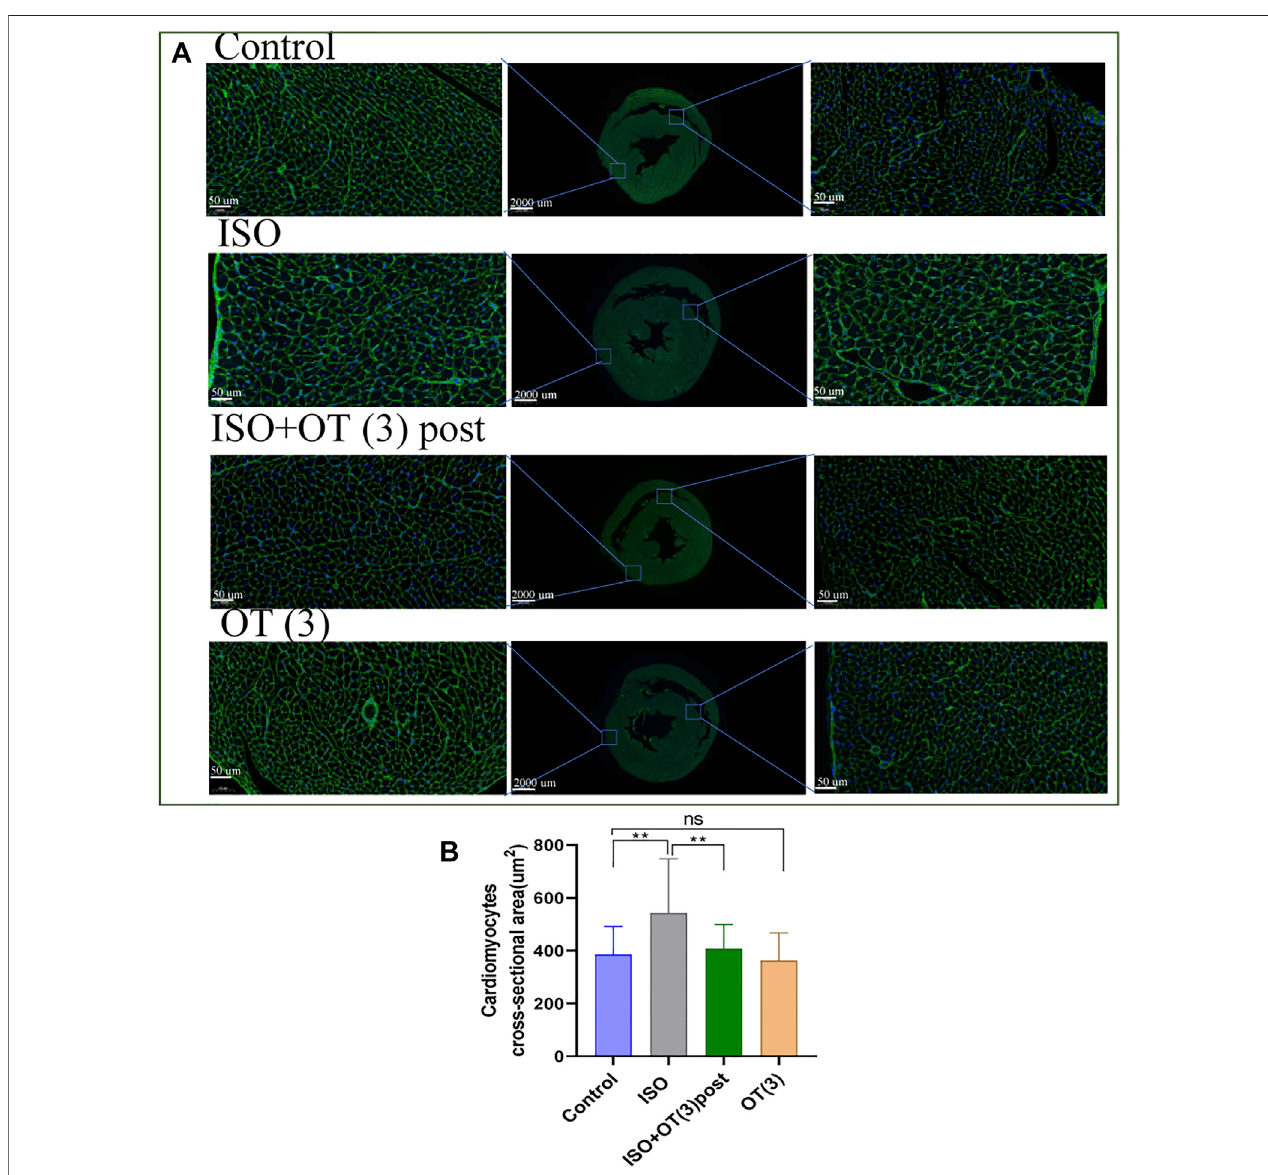
FIGURE 4 | The cross sections of hearts were stained with WGA. (A) The representative images of WGA staining in the cardiomyocyte cross-sectional area. (B) Statistical results of measurement of cross-sectional areas of cardiomyocytes. Data are shown as mean ± sd, * p < 0.05 ** p < 0.01.